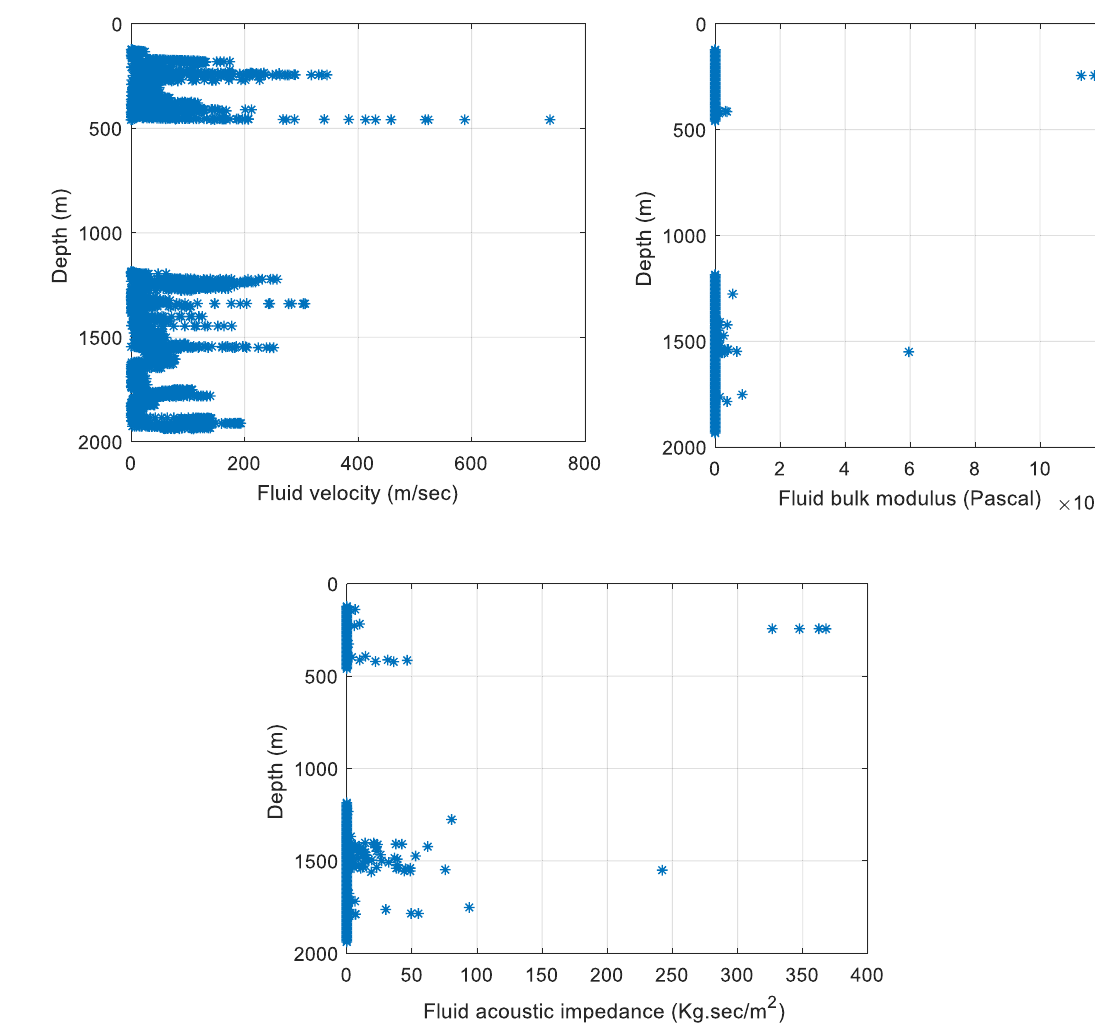
Fig. 13 Fluid velocity, bulk modulus, and acoustic impedance of